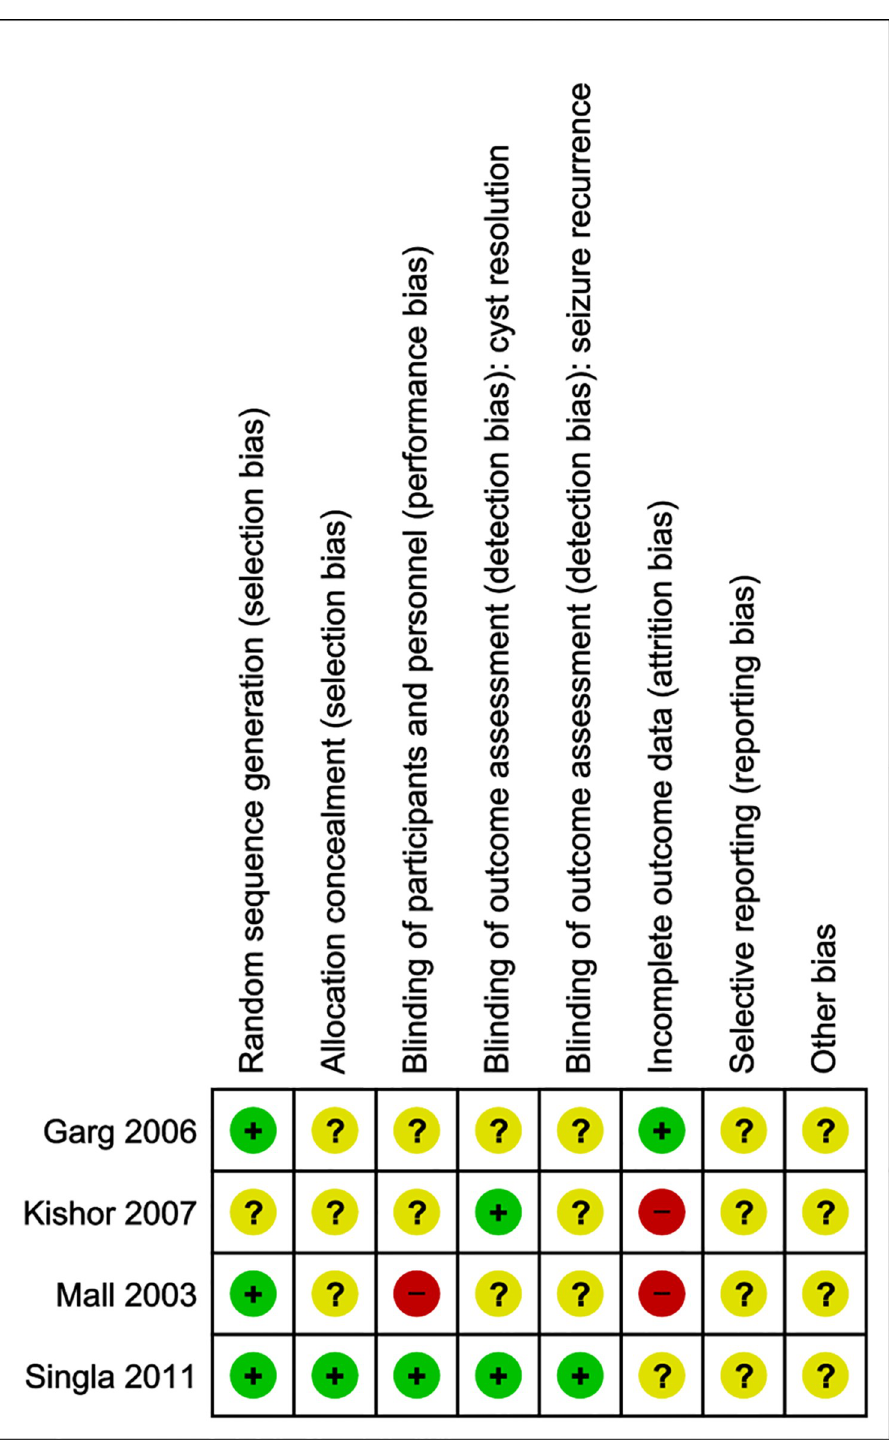
Fig 8. Risk of bias summary—Corticosteroids. Judgement of the two independent reviewers about each risk of bias item for the included studies.